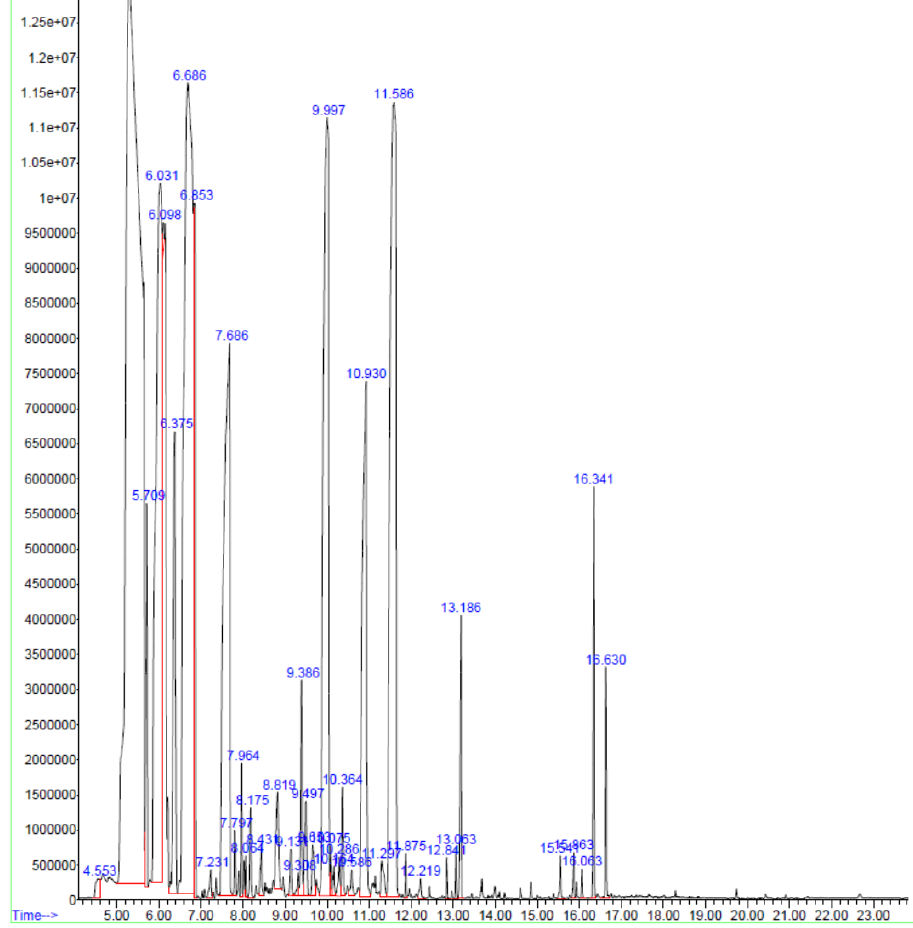
Figure 1. GCMS chromatogram of frankincense oil.